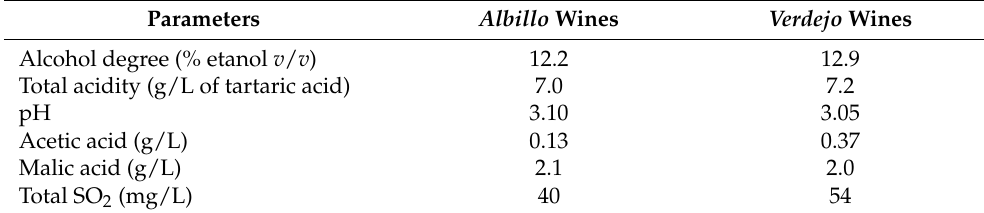
Table 2. Oenological parameters of the white wines before the